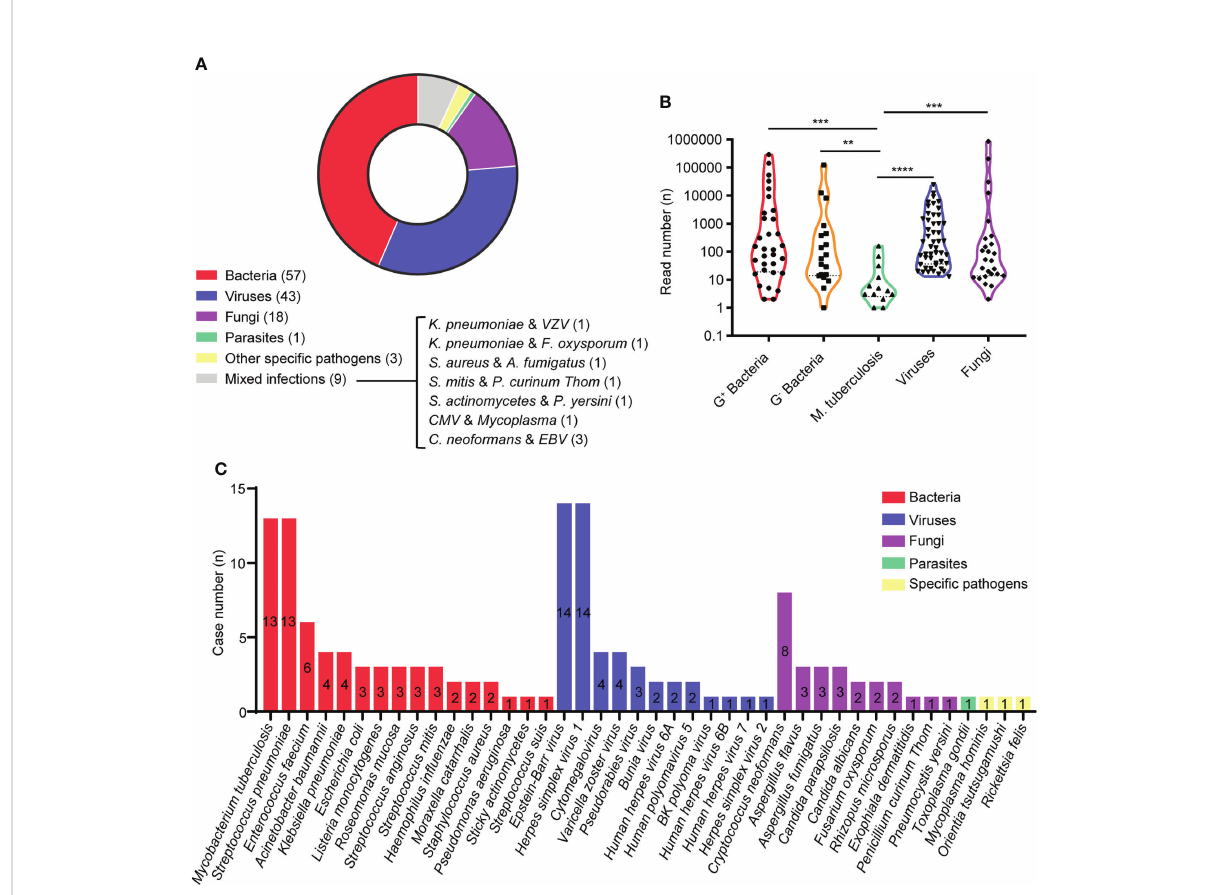
FIGURE 2 Etilolgy of CA-CNS infections identi fi ed by mNGS in the present study. (A) Pie charts demonstrated the distribution of different types of microbial infections. (B) Violin polot showed read numbrers of pathogen species. G + bacteria (n = 32); G - bacteria (n = 19); Mycobacterium tuberculosis (n = 13); viruses (n = 49); fungi (n = 26). Data were analyzed by Mann-Whitney test. (C) A total of 40 different species of pathogens were detected in the different infectious groups with their corresponding frequencies plotted in histograms. ** p < 0.01, *** p < 0.001, **** p <